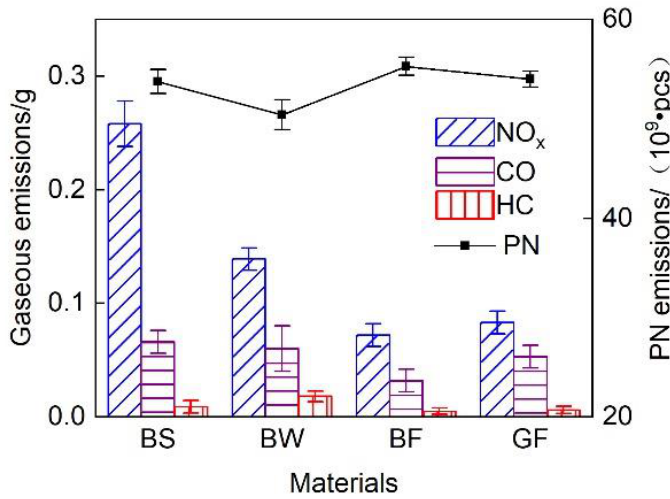
Figure 11. Total emissions during the WHTC cycle.